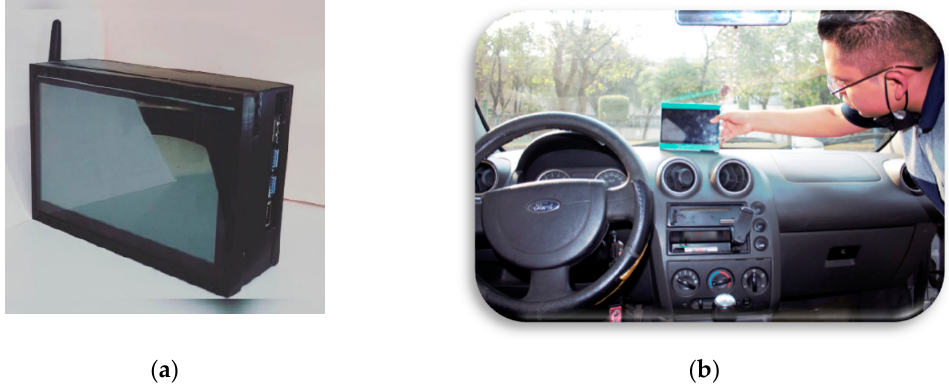
Figure 24. SOMN_IA. ( a ) The outward appearance of the SOMN_IA (black version); ( b ) the installation of the SOMN_IA (green version) inside of a vehicle.